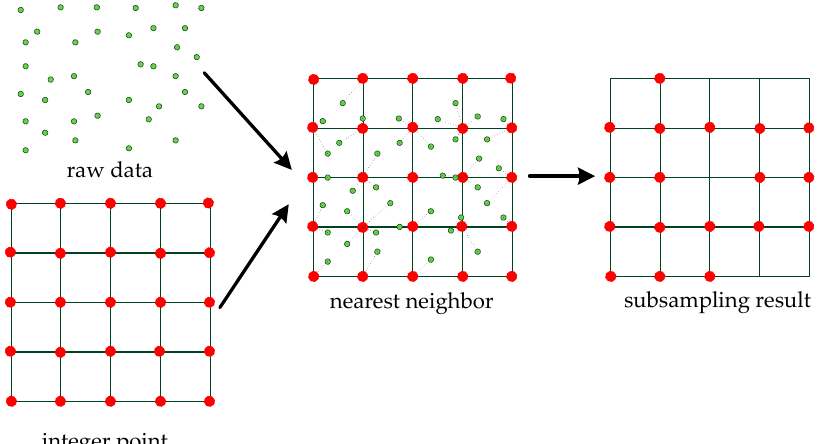
Figure 8. The grid subsampling method. Given the coordinates of integer points, each point in the raw data is updated to the nearest integer point. The shape of the data is retained and the amount of data is reduced in the subsampling result S p .